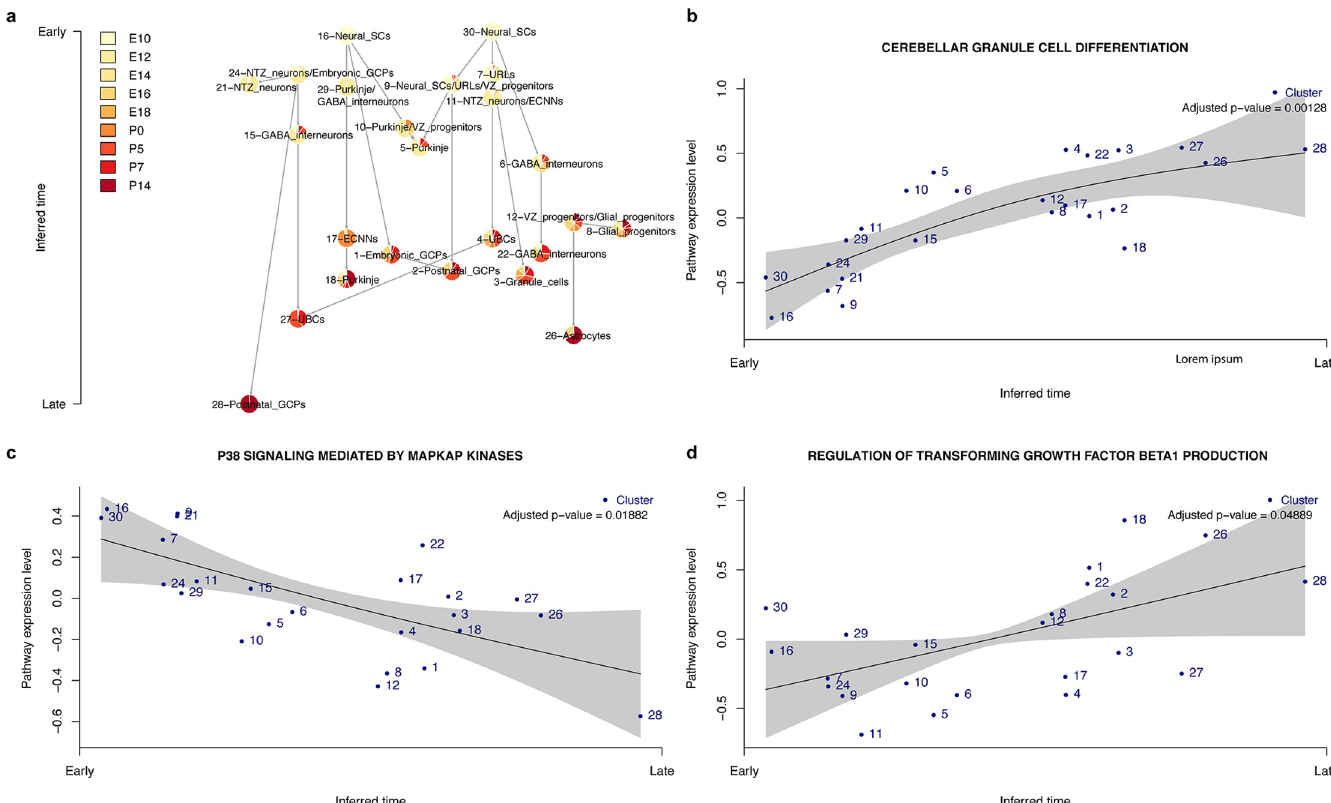
Fig 4. Tempora analysis of the murine cerebellar data set. a. Tempora trajectory built on clusters in the murine cerebellar data set. b-d. Time-dependent pathways in the murine cerebral cortex data set identified by Tempora’s pathway exploration feature. Blue dots represent clusters/cell types, the black line is the best fit of a generalized additive model (GAM) on the pathway enrichment scores of each pathway across all clusters, and grey areas depict 95% confidence intervals of the fitted model.